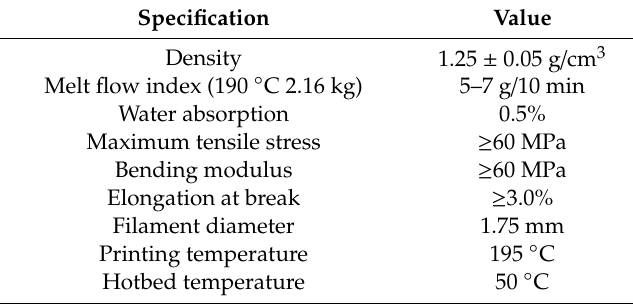
Table 1. Material specifications and processing recommendations for polylactic acid (PLA) filaments used.